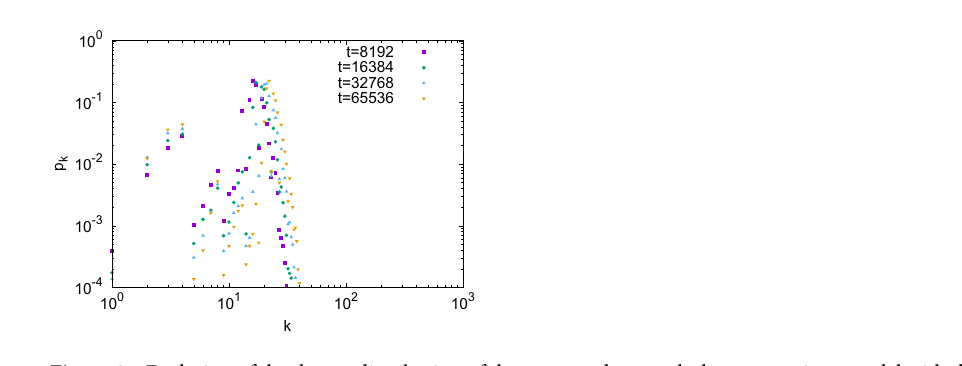
1 and thus the map G is simply given by G ( x ′ ) =